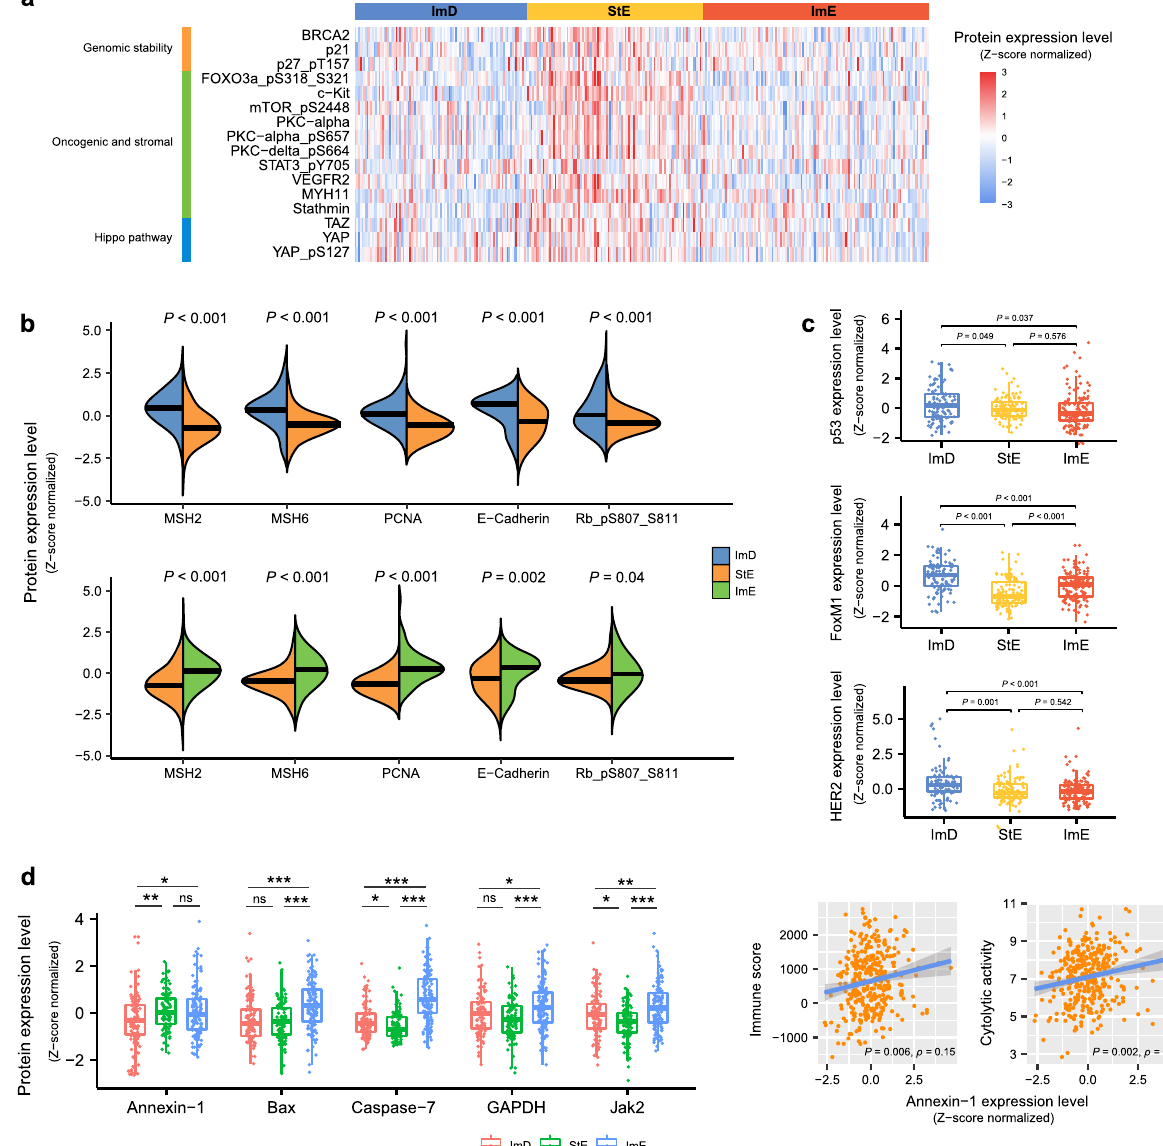
Fig. 6 Comparisons of protein expression pro fi les between the three GC subtypes in TCGA-STAD. a Heatmap showing that the proteins maintaining genomic stability, correlating with oncogenic and stromal signatures, and regulating the Hippo pathway display signi fi cantly higher expression levels in StE than ImD and ImE (two-tailed Student ’ s t test, false discovery rate < 0.05). b The DNA repair, cellular adhesion, and tumor suppression proteins displaying signi fi cantly lower expression levels in StE than ImD and ImE. c , d Comparisons of the expression levels of p53, FoxM1, HER2, Annexin-1, Bax, Caspase-7, GAPDH, and Jak2 between the three GC subtypes, and Spearman correlations between Annexin-1 expression levels and immune signature scores. The two-tailed Student ’ s t test P values are indicated in ( b – d ). * P < 0.05, ** P < 0.01, *** P <